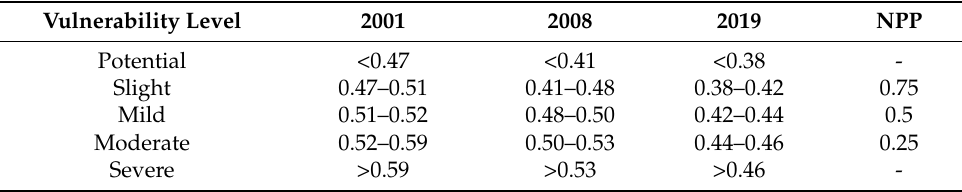
Table 2. Table of EV levels in the DRB in different